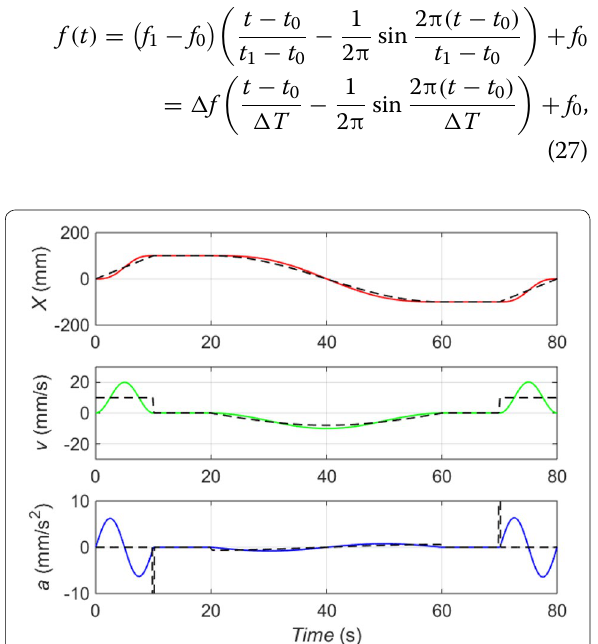
Figure 7 Planned and unplanned trajectories for fifth degree polynomial